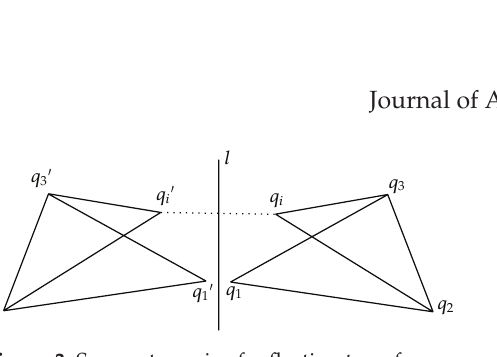
Figure 3: Symmetry axis of reflection